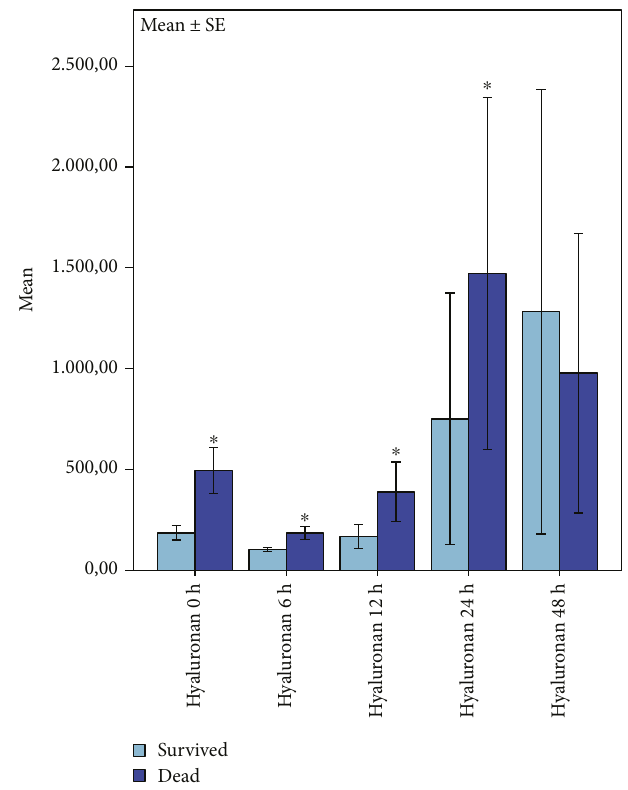
Figure 3: Plots of correlation between hyaluronan levels and 30-day survival 0 h-48h after cardiac arrest. Signi fi cant correlation of hyaluronan levels and survival 0h-24h after ROSC; bars represent mean values with error bars representing ± 1 SE. MANOVA analysis of variances and the post hoc ∗ Mann-Whitney U test; p ≤ 0 05 ; survivors n = 9 , nonsurvivors n = 6